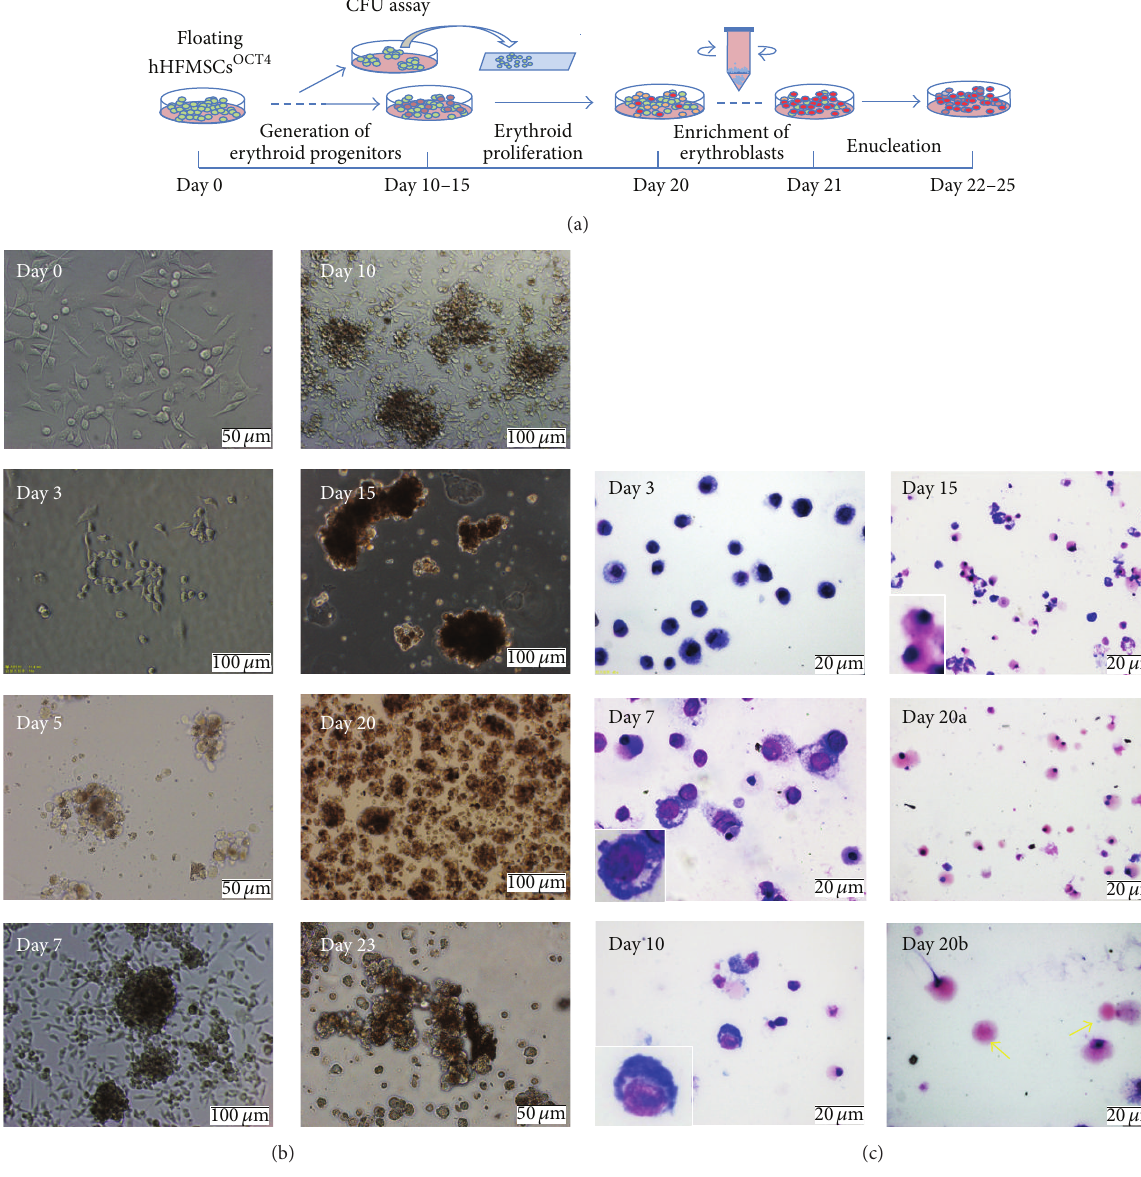
Figure 3: Transdifferentiation of hHFMSCs OCT 4 into erythrocytes. (a) Schematic of transdifferentiation strategy. (b) Phase-contrast images represented progressive generation of hHFMSC-derived erythroblasts in vitro (day 0, day 5, and day 23: original magnification × 200; day 3, day 7, day 10, day 15, and day 20: original magnification × 100). (c) Wright-Giemsa staining detected progressive generation of hHFMSC- derived erythroblasts in vitro (day 3, day 7, day 10, and day 20b: original magnification × 400; day 15 and day 20a: original magnification ×